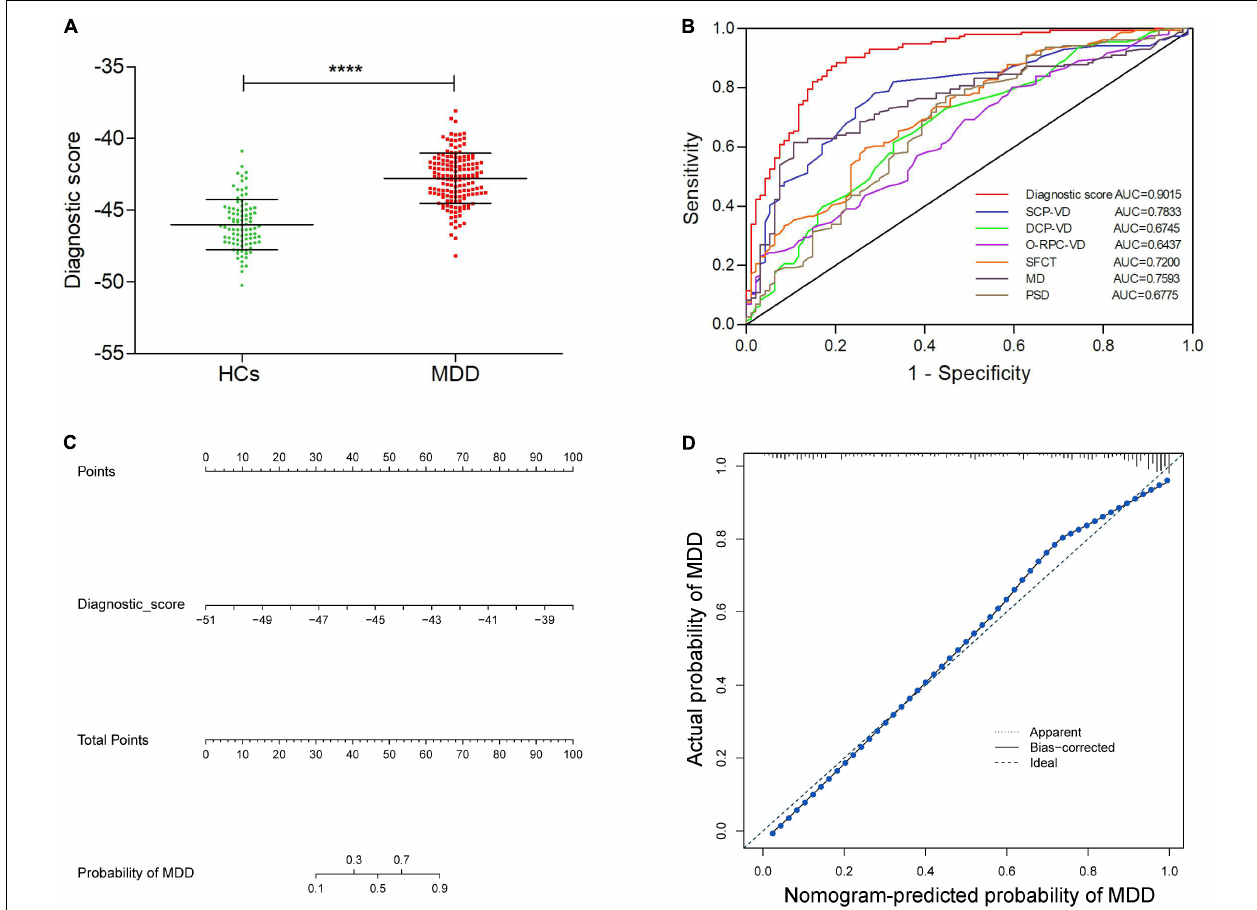
FIGURE 3 | Identification of the value of retina-based diagnostic scores, and establishment and validation of a visual nomogram. (A) Comparison of diagnostic scores between MDD group and HCs. (B) ROC curves exhibiting the diagnostic efficacy of the retina-based diagnostic score and the six retinal parameters alone. (C) The nomogram based on the retina-based diagnostic score for MDD. (D) The calibration curve of the nomogram. **** p < 0.0001. HCs, healthy controls; MDD, major depressive disorder; SCP-VD, superficial capillary plexus vessel density; DCP-VD, deep capillary plexus vessel density; O-RPC-VD, outer-circle radial peripapillary capillary vessel density; SFCT, subfoveal choroidal thickness; MD, mean deviation; and PSD, pattern standard